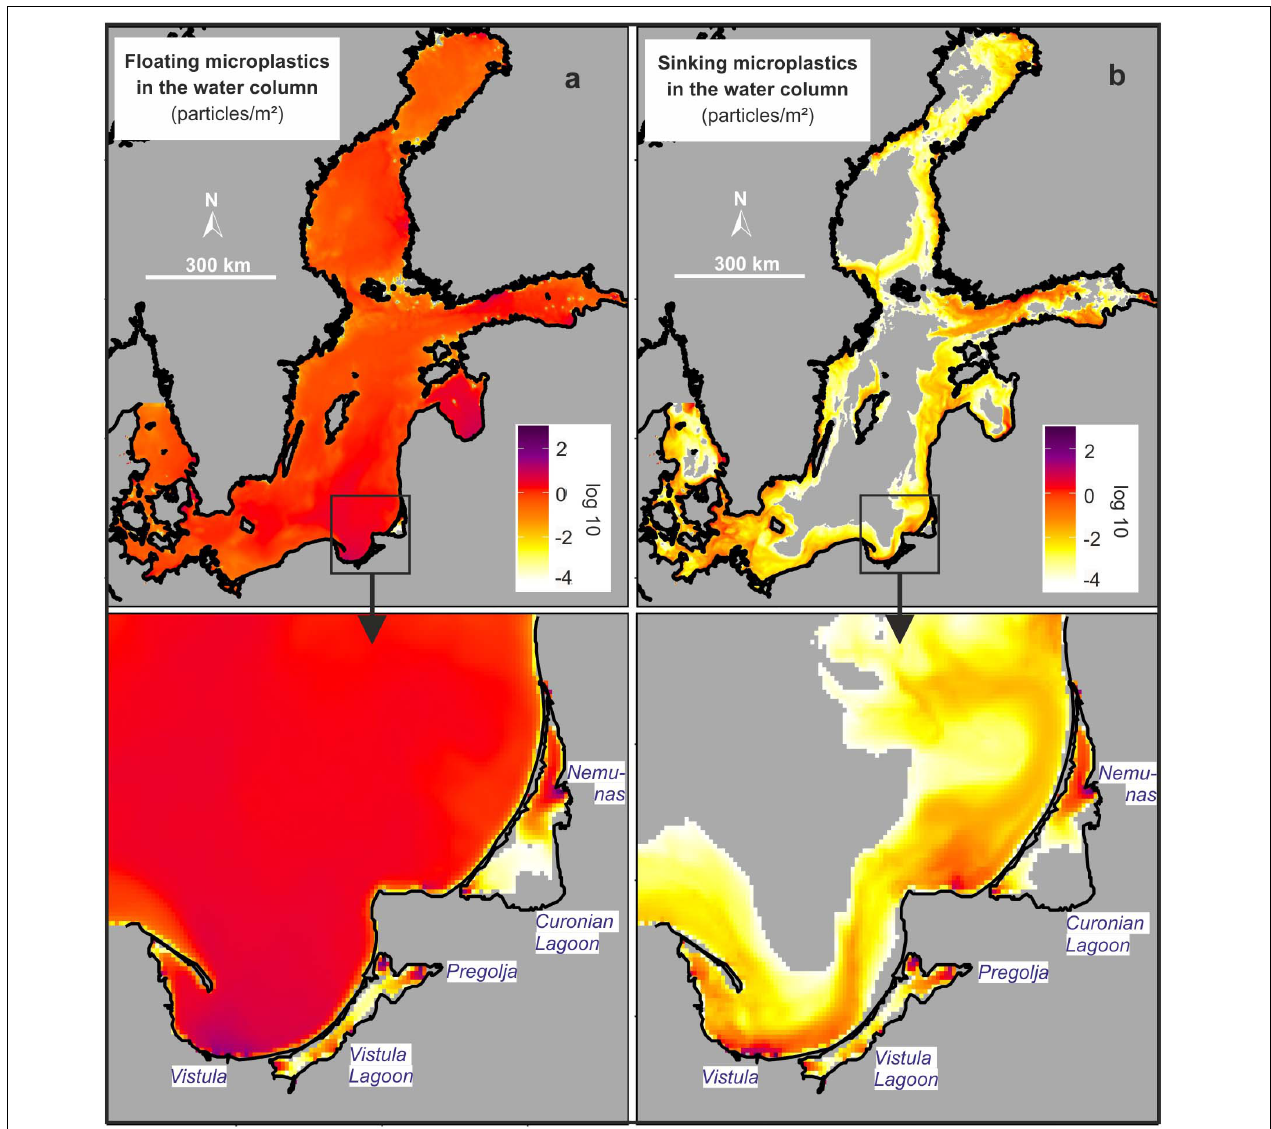
FIGURE 4 | Average annual spatial concentration of (a) floating and (b) sinking microplastic particles (20–500 µ m size fraction) in the water column in the Baltic Sea and the wider Bay of Gdansk based on simulations with a 3D hydrodynamic model. Grey areas in the sea indicate concentration below the colour